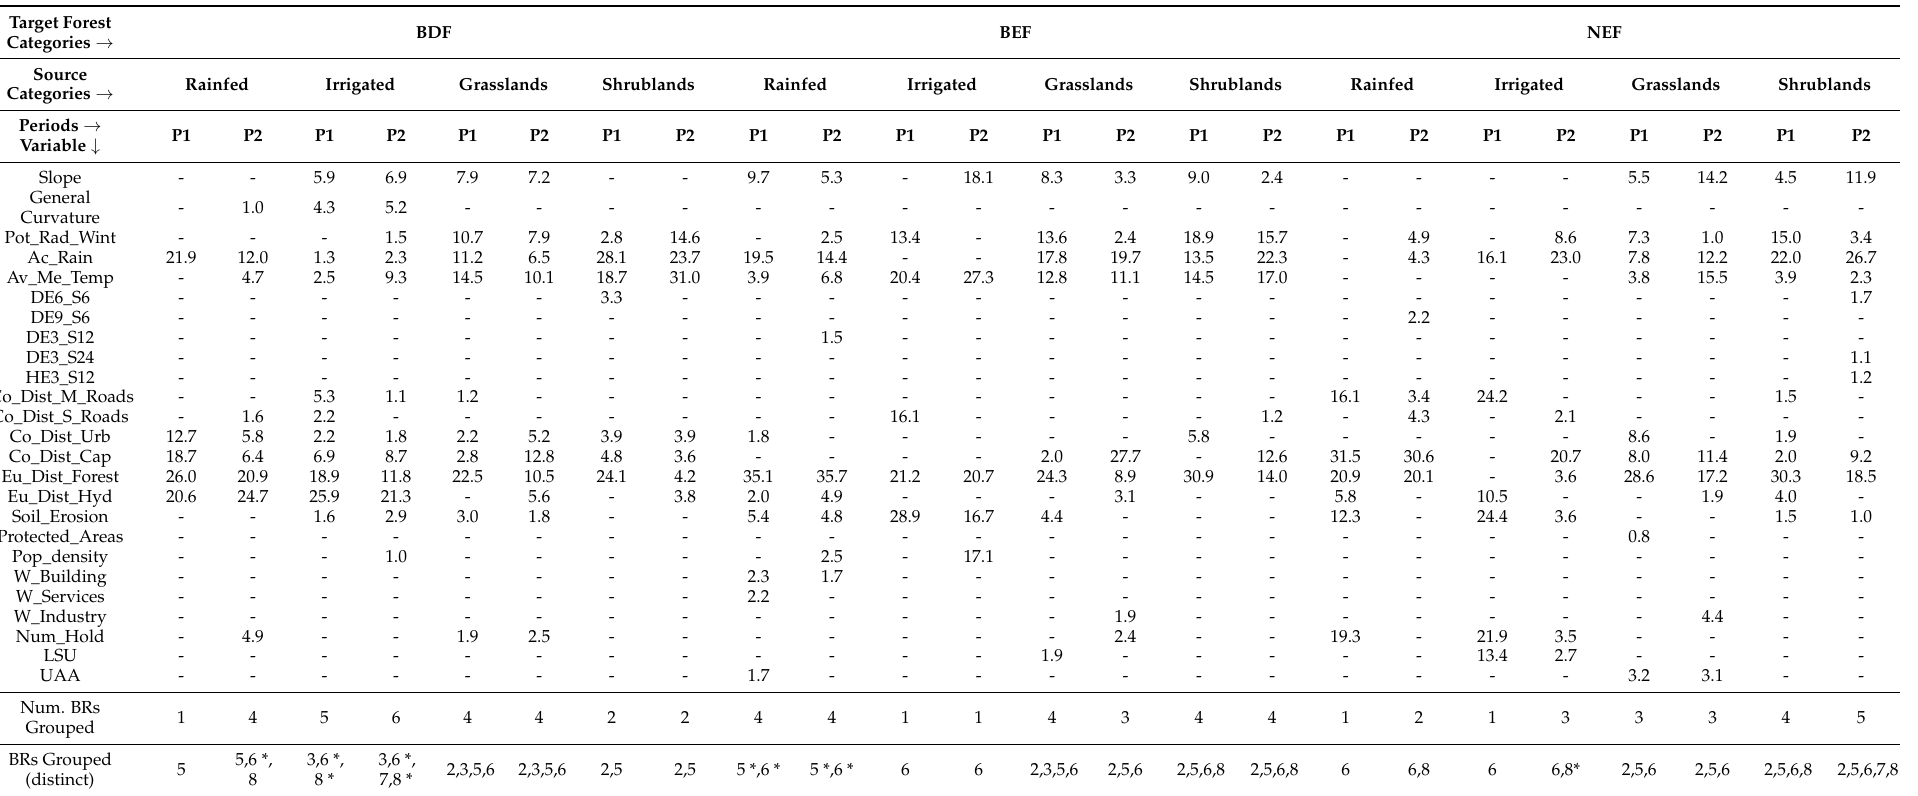
Table 4. Aggregated, weighted, and scaled relativ importance values are detailed for each predictor, source category, and new forests’ target category. The “Irrigated” label groups are IHC and IWC, while “Rainfed” groups are RHC and RWC